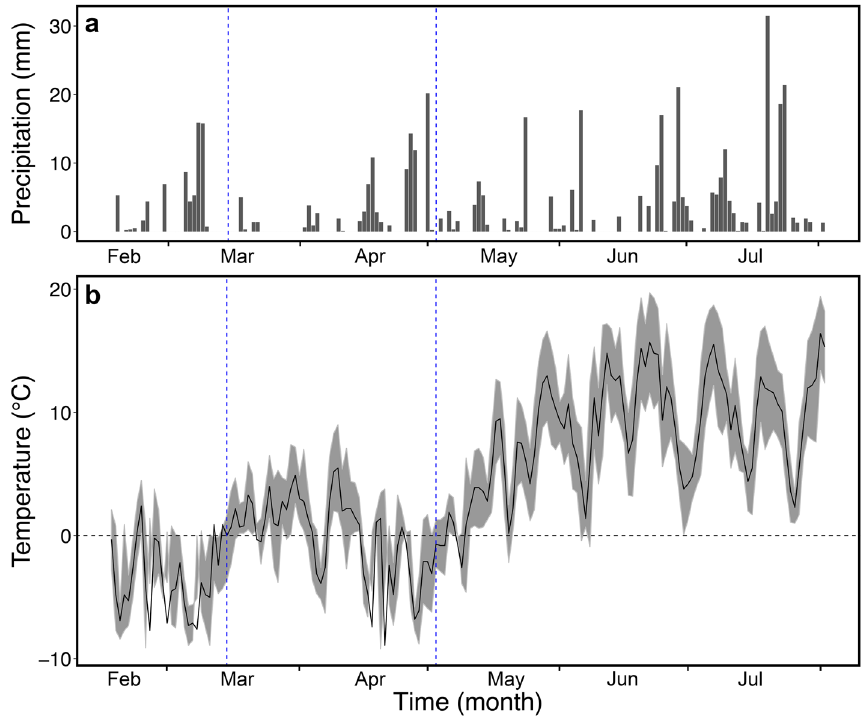
Figure 2. Meteorological data. Daily mean air temperature ( a ; gray area delimits daily min and max temperature) and daily cumulated precipitation ( b ) from February 16th to August 2nd, 2017, collected